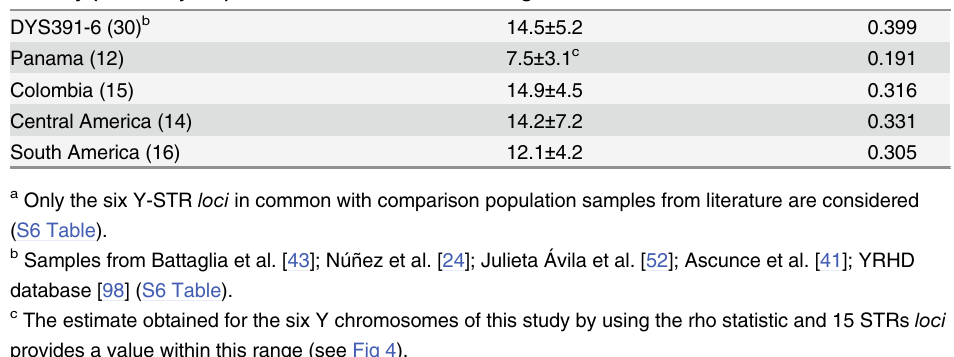
Table 4. Estimated coalescent ages a for the Q-DYS391-6 lineage in Central and South America. Country (n. of subjects)